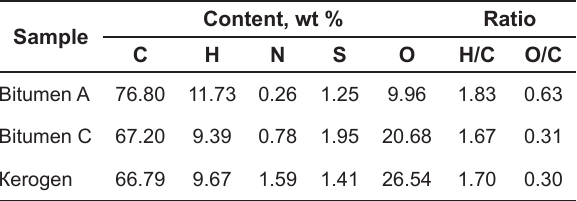
Table 2. Elemental compositions of Uvurjargalant’s oil shale, wt %